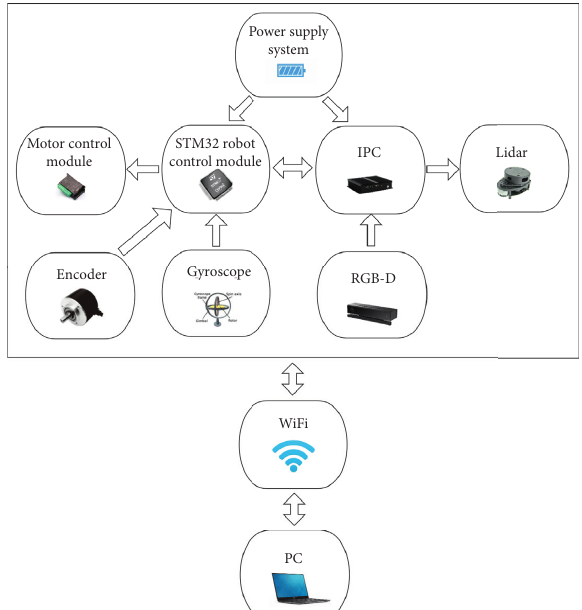
Figure 1: System structure of our mobile robot. “STM32 robot control module” gets information of motors from “encoder” and motion from “gyroscope” to control motors and transfer the motion and encoder information to “IPC” which is a microcomputer. Then, “IPC” gets information from Lidar, “STM32 robot control module,” and RGB-D camera.